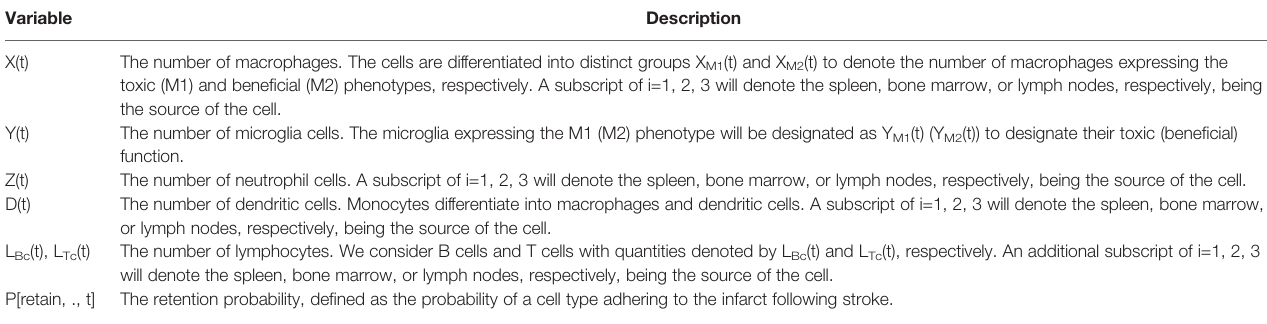
TABLE 1 | A litanyofthe variables discussedas being important inthe in fl ammatory response following strokeand used to quantify the processes considered inthis work. Variable